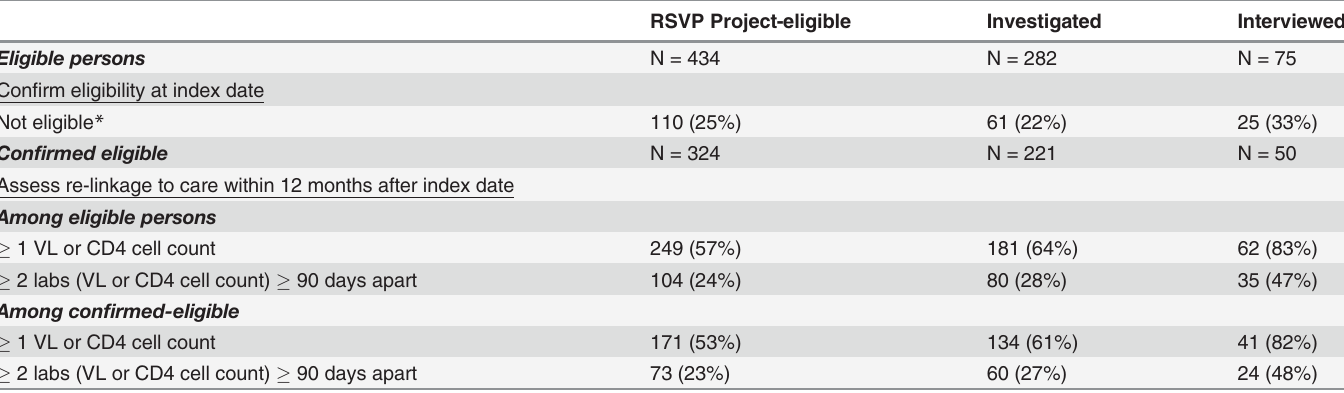
Table 2. Match-back to eHARS data available 12 months after index date to con fi rm persons ’ original eligibility and to assess re-engagement in care based on new HIV laboratory data, the RSVP Project, San Francisco, 2012 –